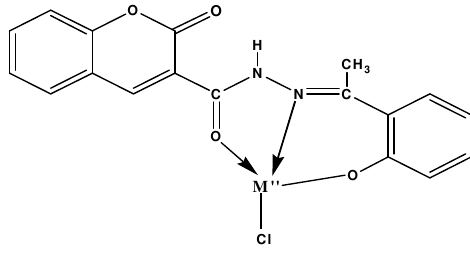
Figure 5 . Sturcture of